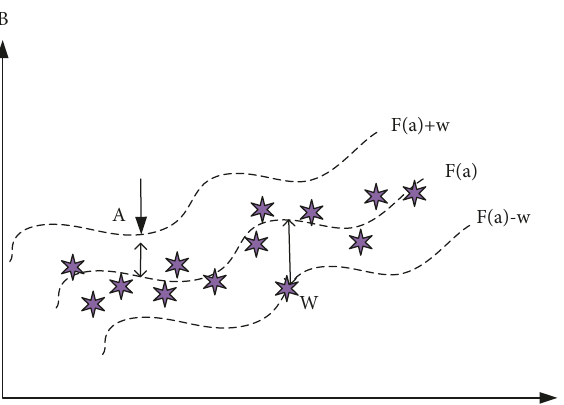
Figure 9: Support vector machine regression.